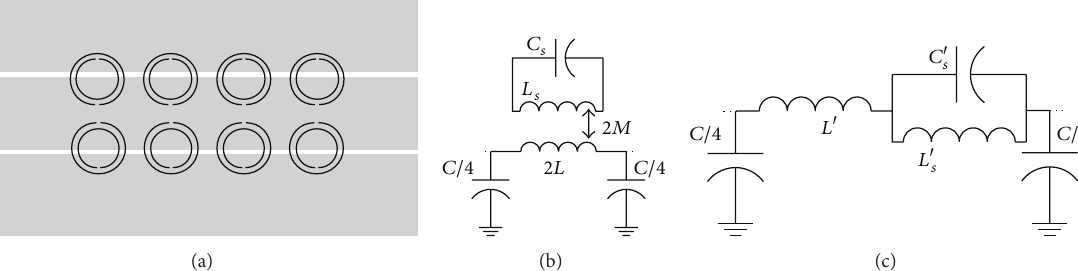
Figure 1: Typical topology (a) and circuit model (b) of a CPW loaded with SRRs. The model of (b) can be transformed to the one depicted in (c). The magnetic wall concept has been